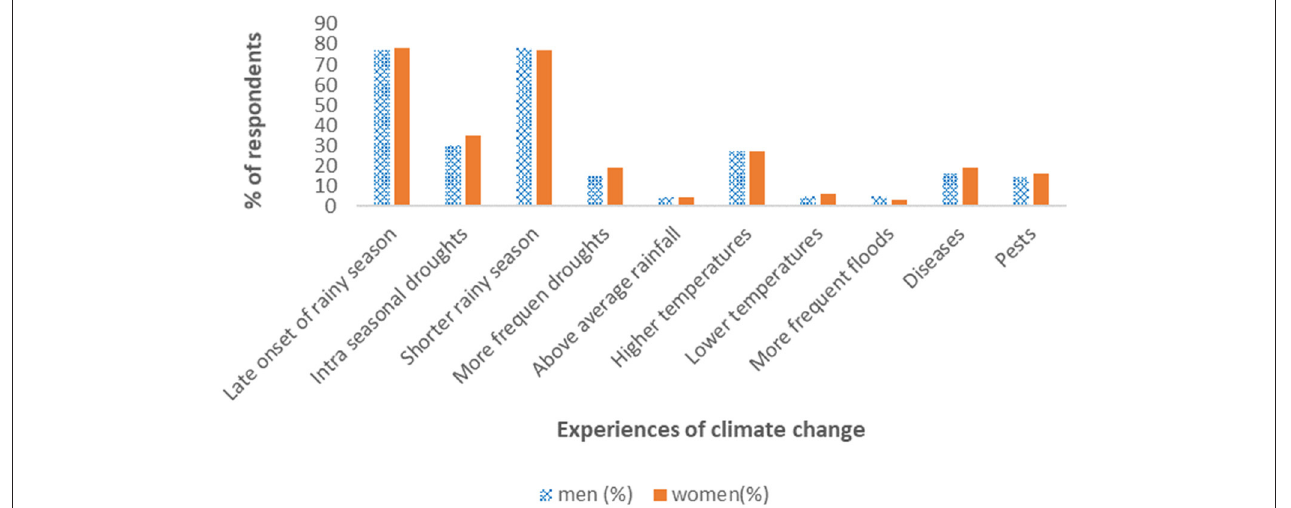
FIGURE 3 | Survey results on experiences of climate change by men and women farmers.